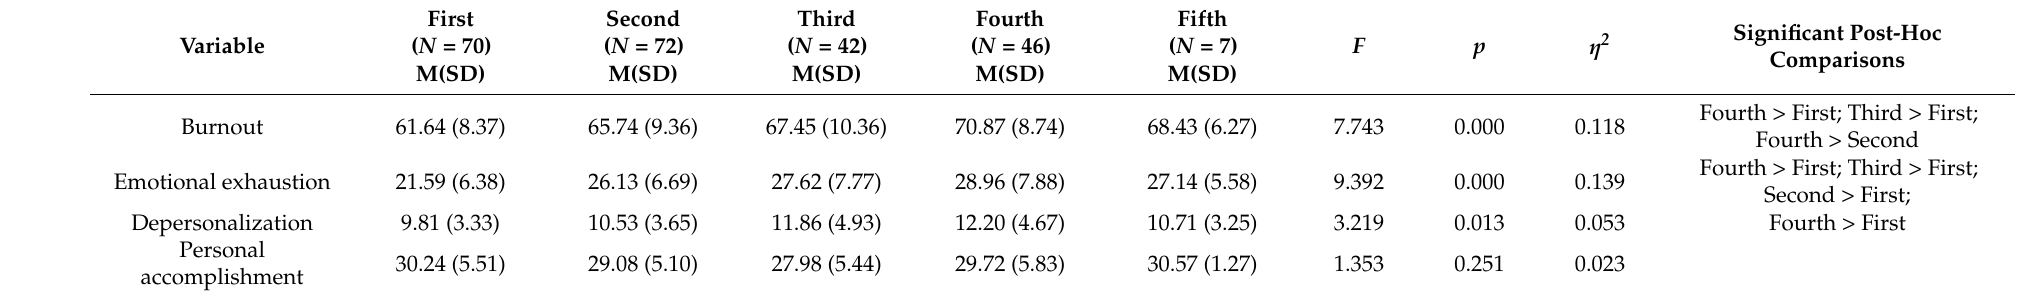
Table 2. Group differences in burnout and its subscales and year of residency.